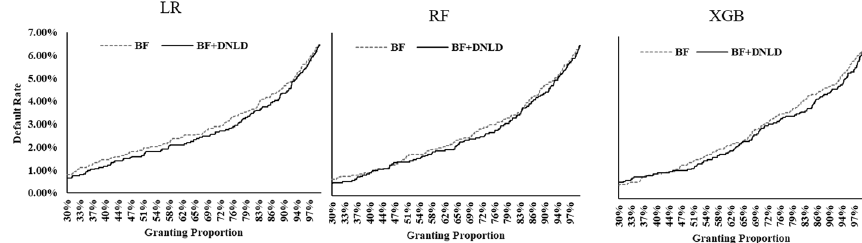
Fig. 6 Granting performance of two models. The horizontal axis shows various loan granting ratios ranging from 30 to 97%. The vertical axis shows the default rate, which ranges from 0 to 6.4%, with the maximum default rate equaling the overall default